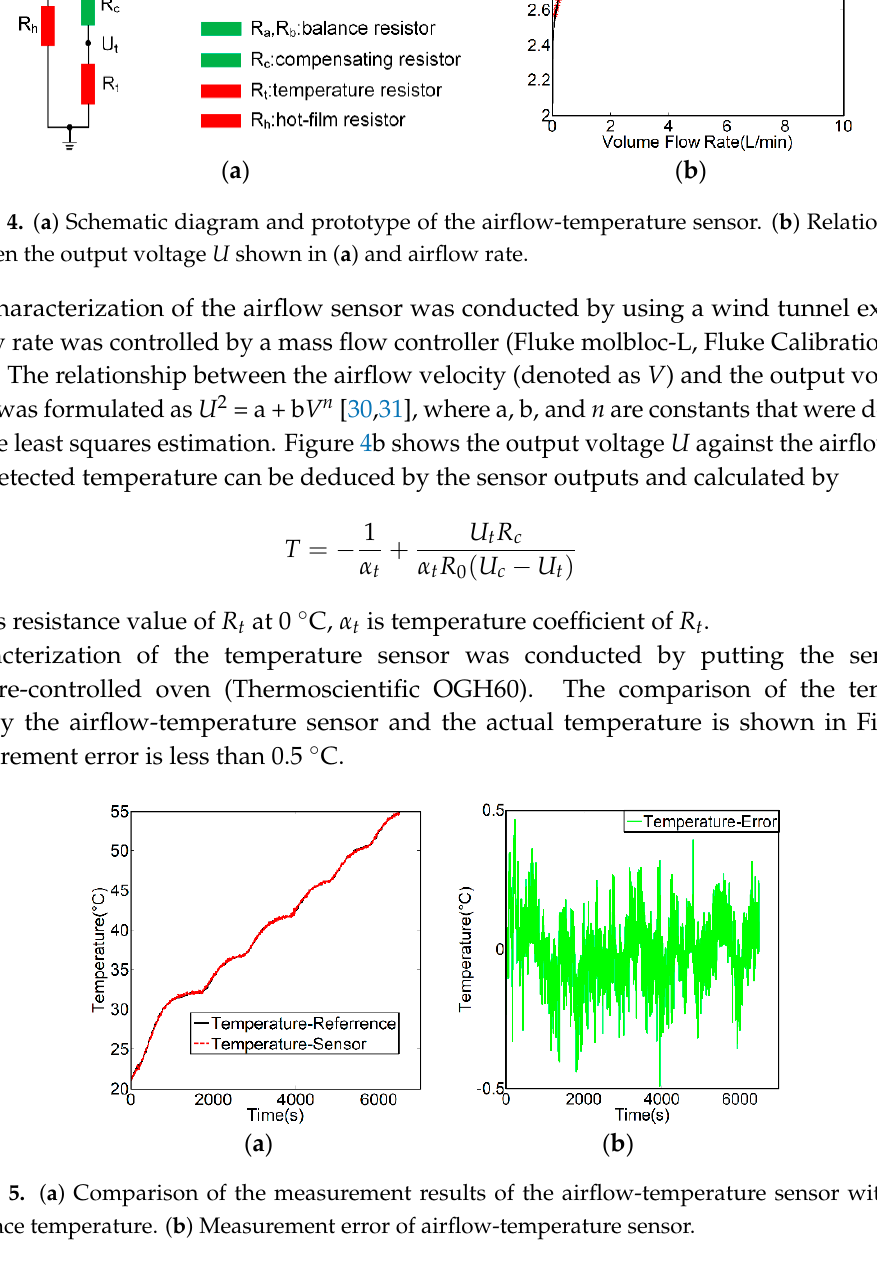
Figure 5. ( a ) Comparison of the measurement results of the airflow-temperature sensor with the reference temperature. ( b ) Measurement error of airflow-temperature sensor.